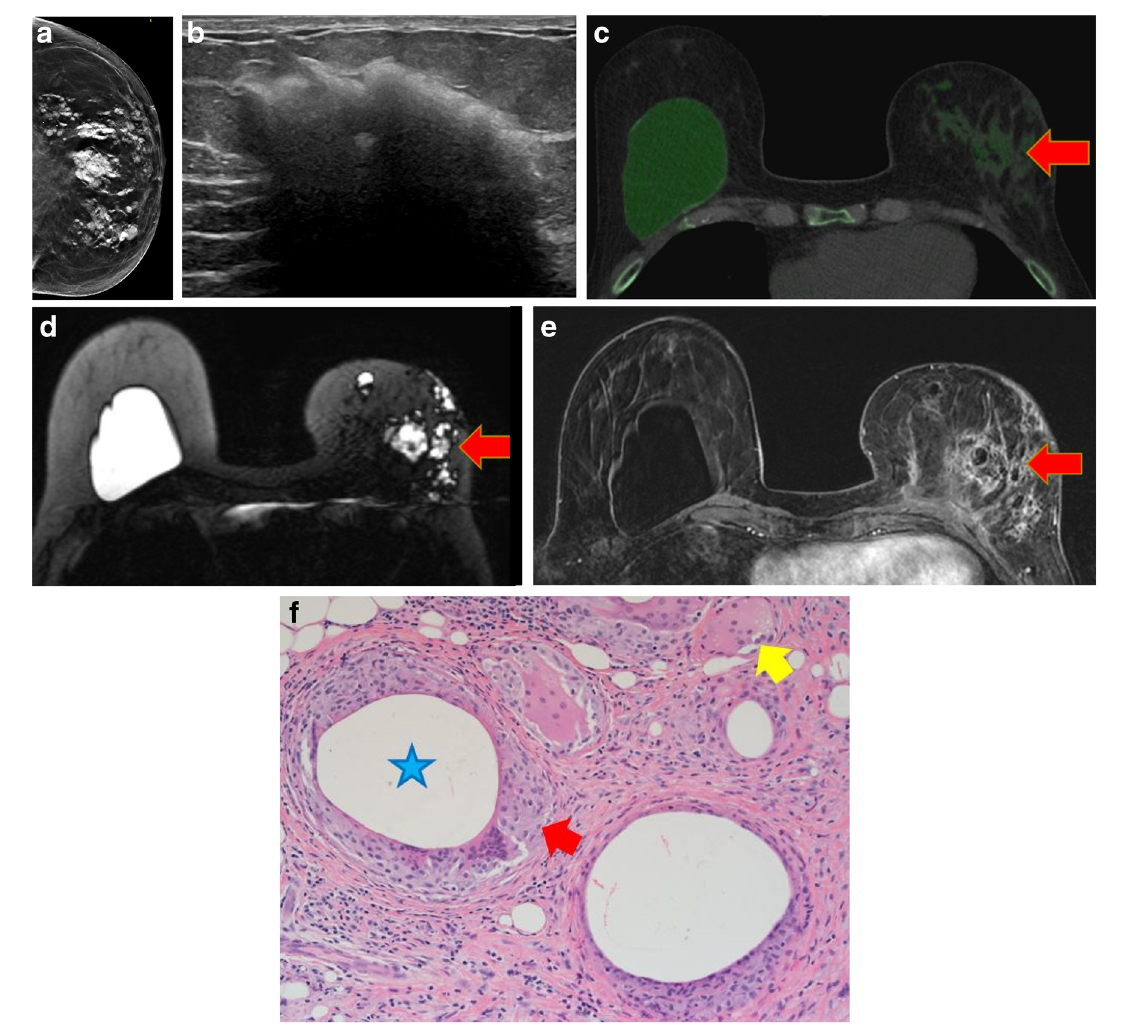
sequence demonstrates the same findings of extracapsular free silicone ( red arrow ) and intact right implant. e Axial post-gadolinium breast MRI showed non-enhancing extracapsular silicone with enhancement sur- rounding the silicone deposits, consistent with granulomatous inflamma- tion ( red arrow ). f Histological photomicrograph (magnification ×20, haematoxylin-eosin) showed B siliconomas ^ with granulomas containing silicone particles ( blue star ), foreign body – type giant cells ( yellow arrow ), foamy macrophages and lymphocytes ( red arrow